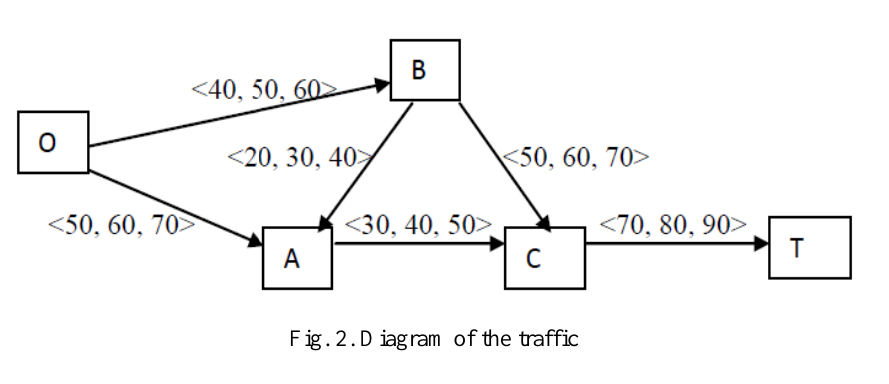
Fig. 2. Diagram of the